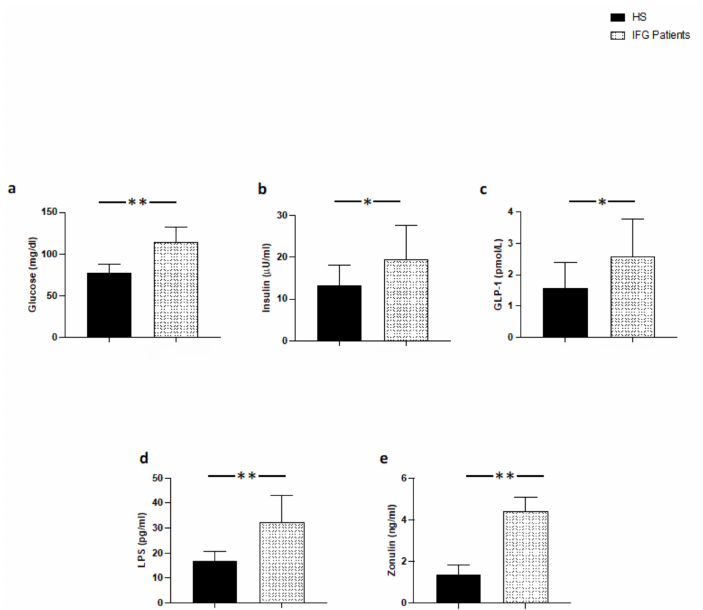
Figure 1. Serum levels of ( a ) glucose, ( b ) insulin, ( c ) GLP-1, ( d ) LPS, and ( e ) zonulin in patients